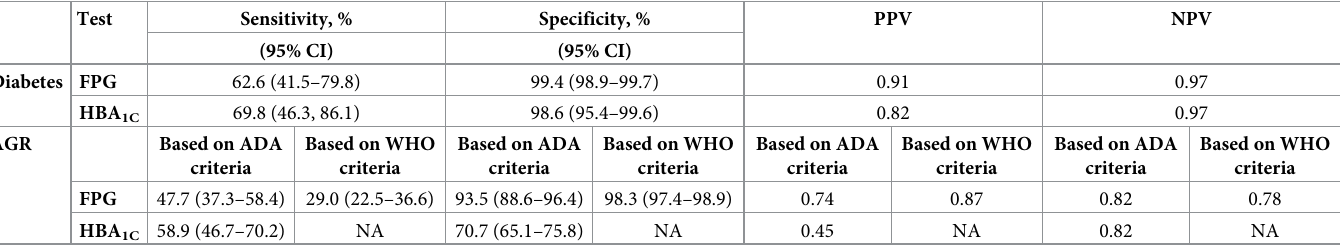
Table 2. Sensitivity, specificity, PPV and NPV of the FPG and HBA 1C tests in the diagnosis of diabetes and AGR at the OGTT cut-offs recommended by ADA and WHO.